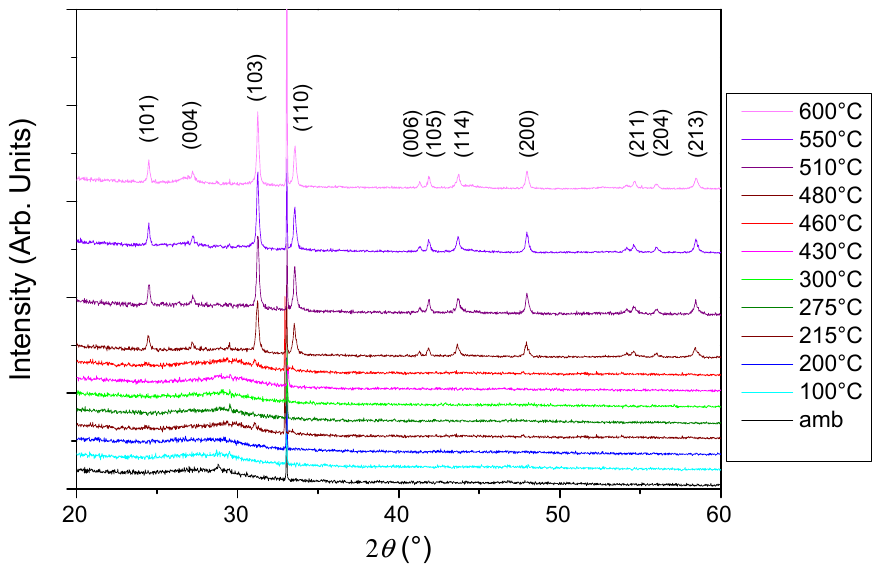
Figure 1. Effect of a 2 h air annealing treatment on the X-ray diffractograms of a La–Cu–O film with an atomic ratio La/Cu of 2.14 deposited on a silicon substrate with a SrTiO 3 sublayer (analysis condition: Co K α radiation).